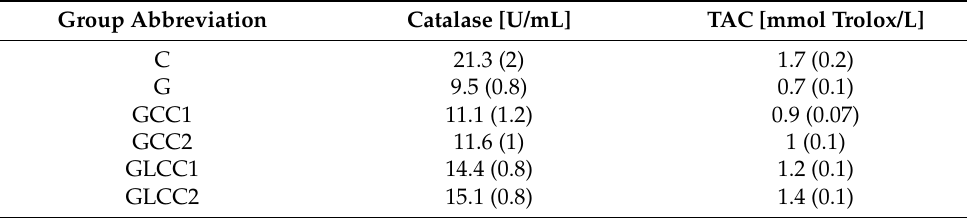
Table 2. Serum levels of antioxidant capacity.